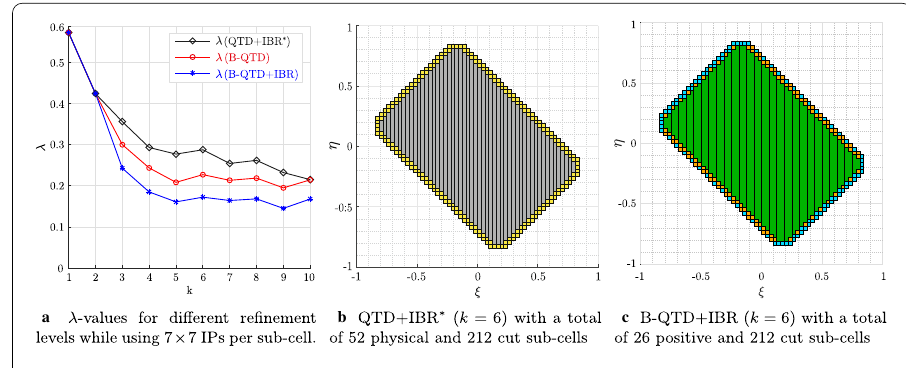
Fig. 20 Comparison of the different reduction techniques the for the example of the superellipse shaped physical domain defined by Eq. (19)